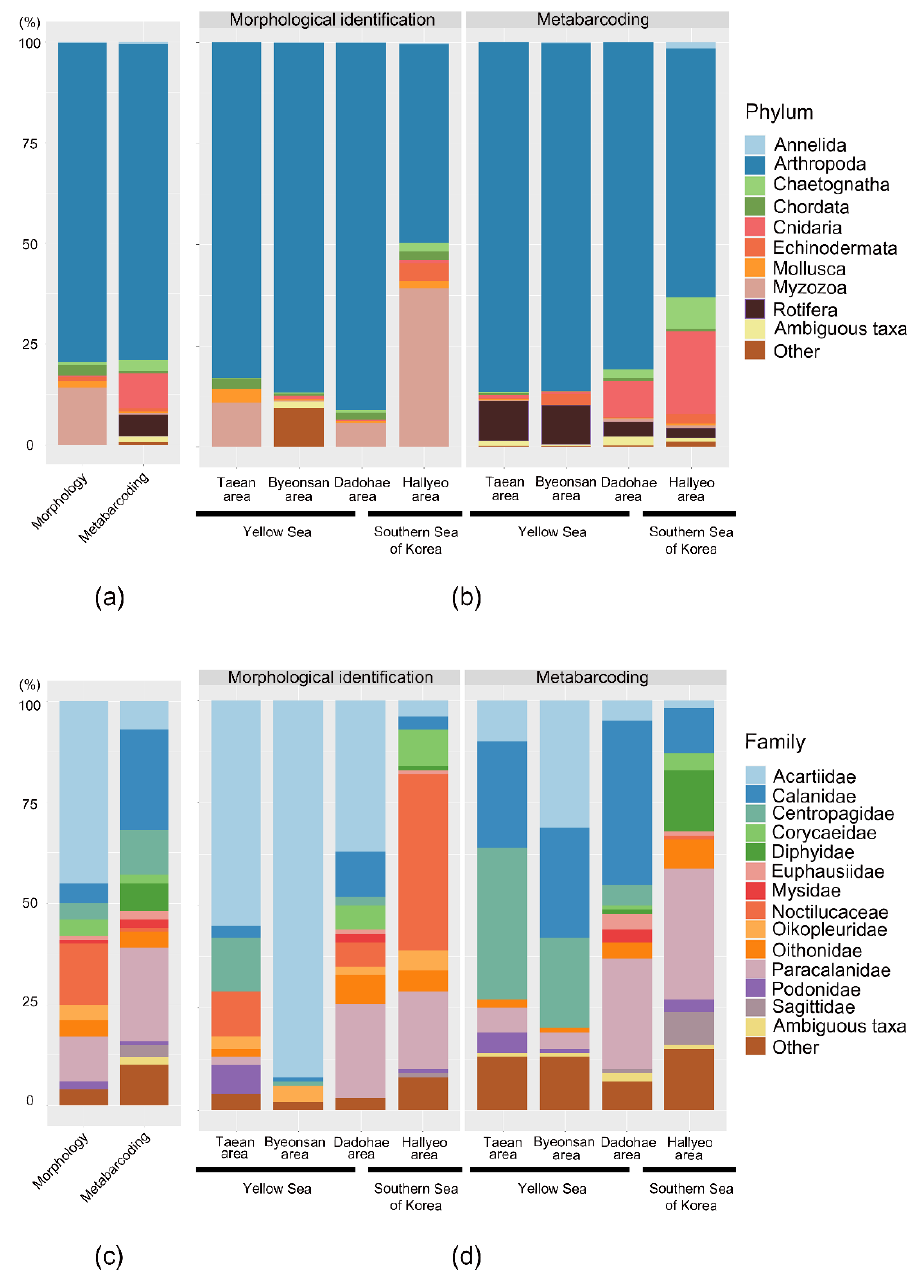
Figure 5. Taxonomic composition of mesozooplankton communities. Bar plots show phylum level proportions according to ( a ) the identification method and ( b ) the sea area and location using morphological identification and metabarcoding. Bar plots show major family level proportions according to ( c ) the identification method and ( d ) the sea area and location using morphological identification and metabarcoding.